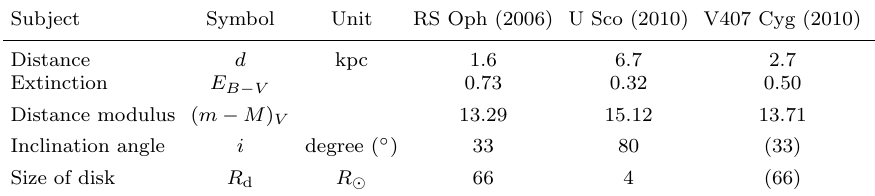
Table 1. Basic model parameters of RS Oph, U Sco, and V407